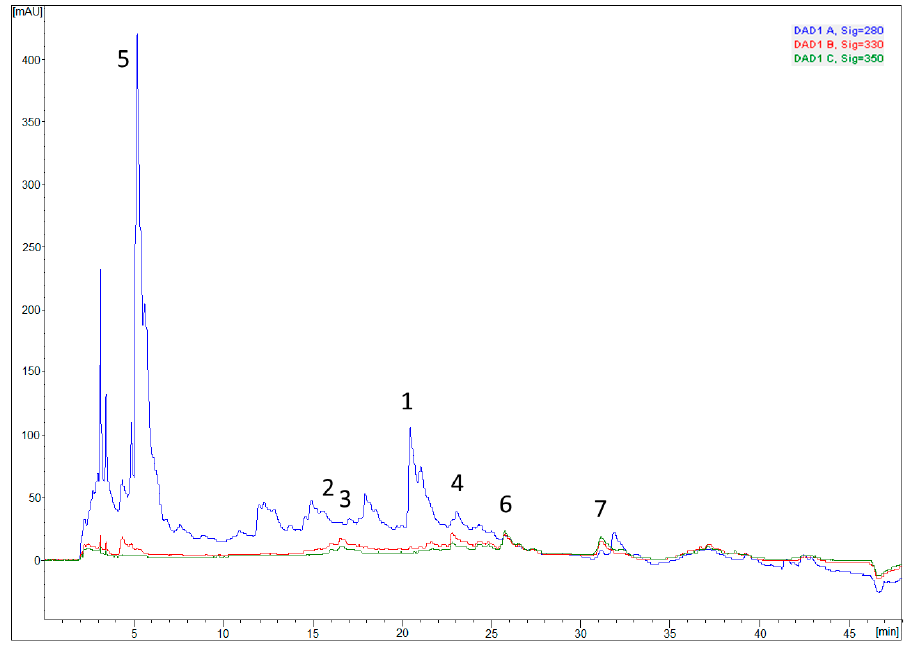
Figure 2. Chromatogram of optimized carob pulp extract with detection at 280, 330 and 350 nm. Iden- tified compounds: 1—caffeic acid; 2— p -coumaric acid; 3—quercetin; 4—chlorogenic acid; 5—gallic acid; 6—rutin; 7—quercitrin.